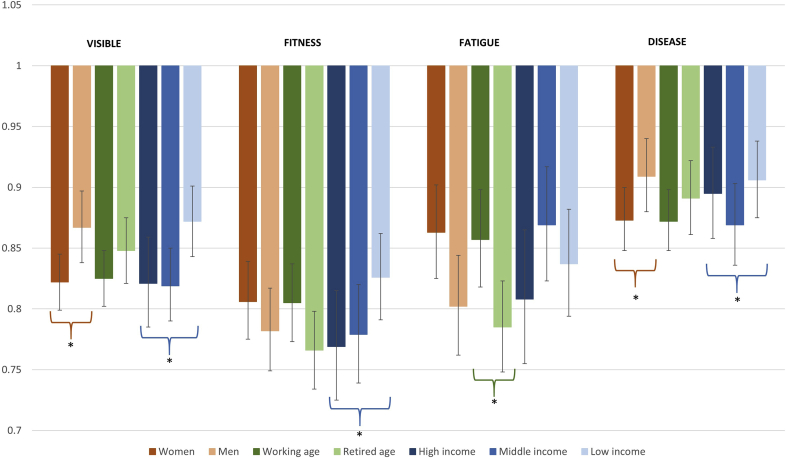
Effect modification by gender, age, and household income of the association between self-rated health and biomarker groups indices. Note: The asterisk (*) denotes a significant modifying effect, based on interaction terms added between the index and the modifying variables under study. Displayed odds ratios and 95% confidence intervals are based on stratified logistic regression analyses by gender, age, and household income groups.